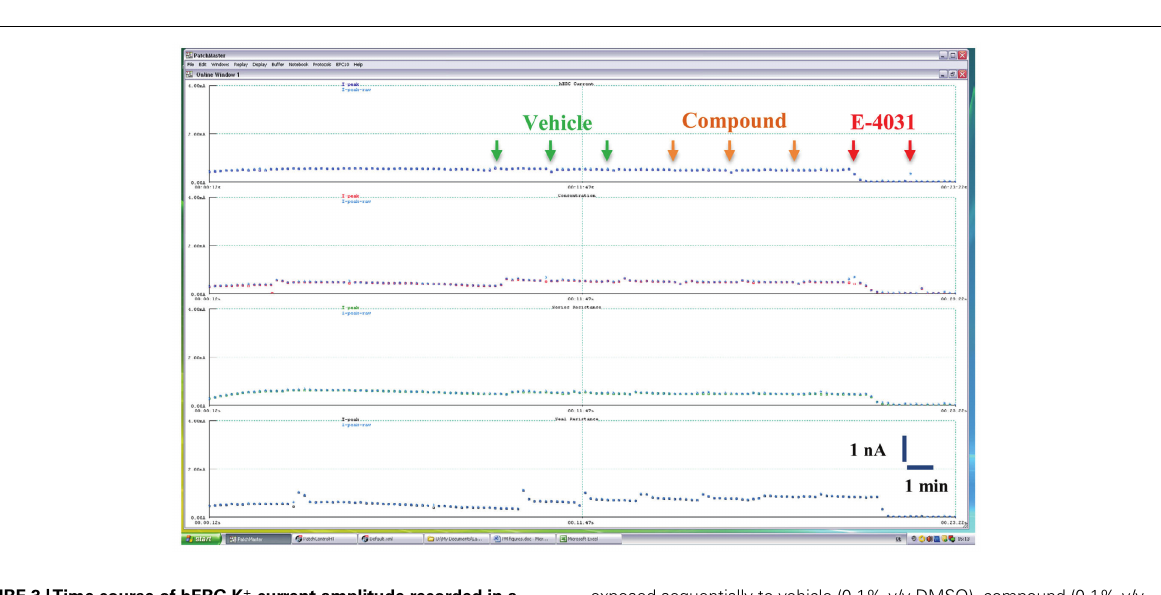
exposed sequentially to vehicle (0.1% v/v DMSO), compound (0.1% v/v DMSO), and 1 μ M E-4031. Arrows indicate compound